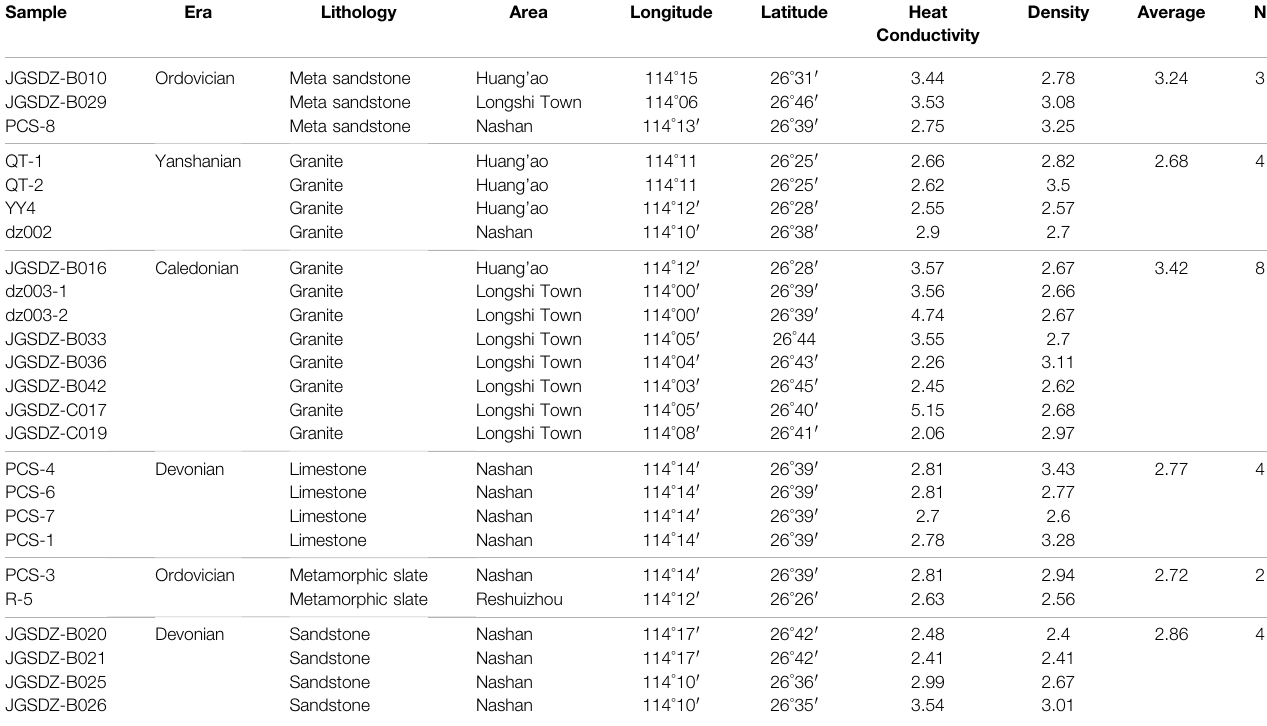
TABLE 3 | Heat conductivity of rocks in the study area. Sample